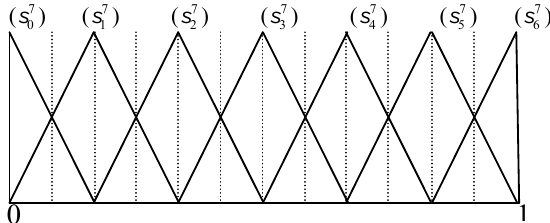
Fig. 3. Membership functions of linguistic variables at level 2 ( t =2)